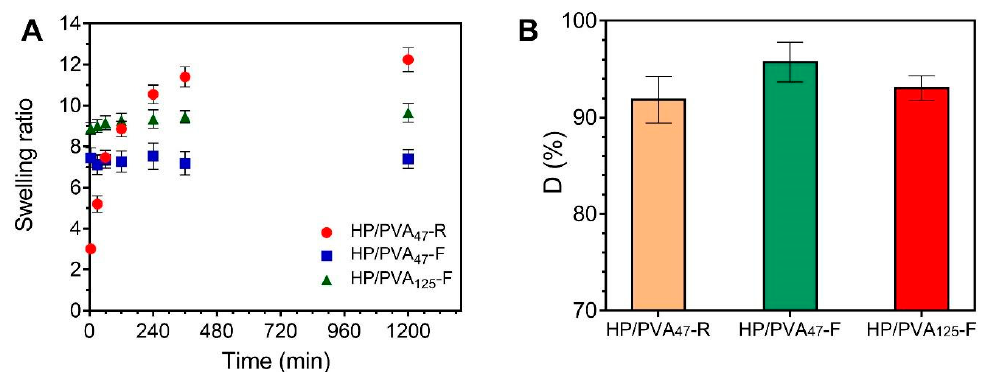
Figure 4. Swelling kinetics of HP/PVA composite hydrogels in simulated physiological conditions